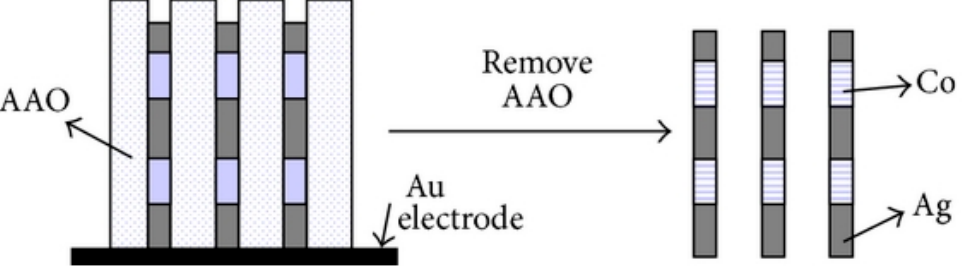
Figure 4. The synthesis process of the mechanism of nanowires via PAA templates. Reproduced from Ref. [31] under the Creative Commons Attribution 4.0 International (CC BY 4.0) License.